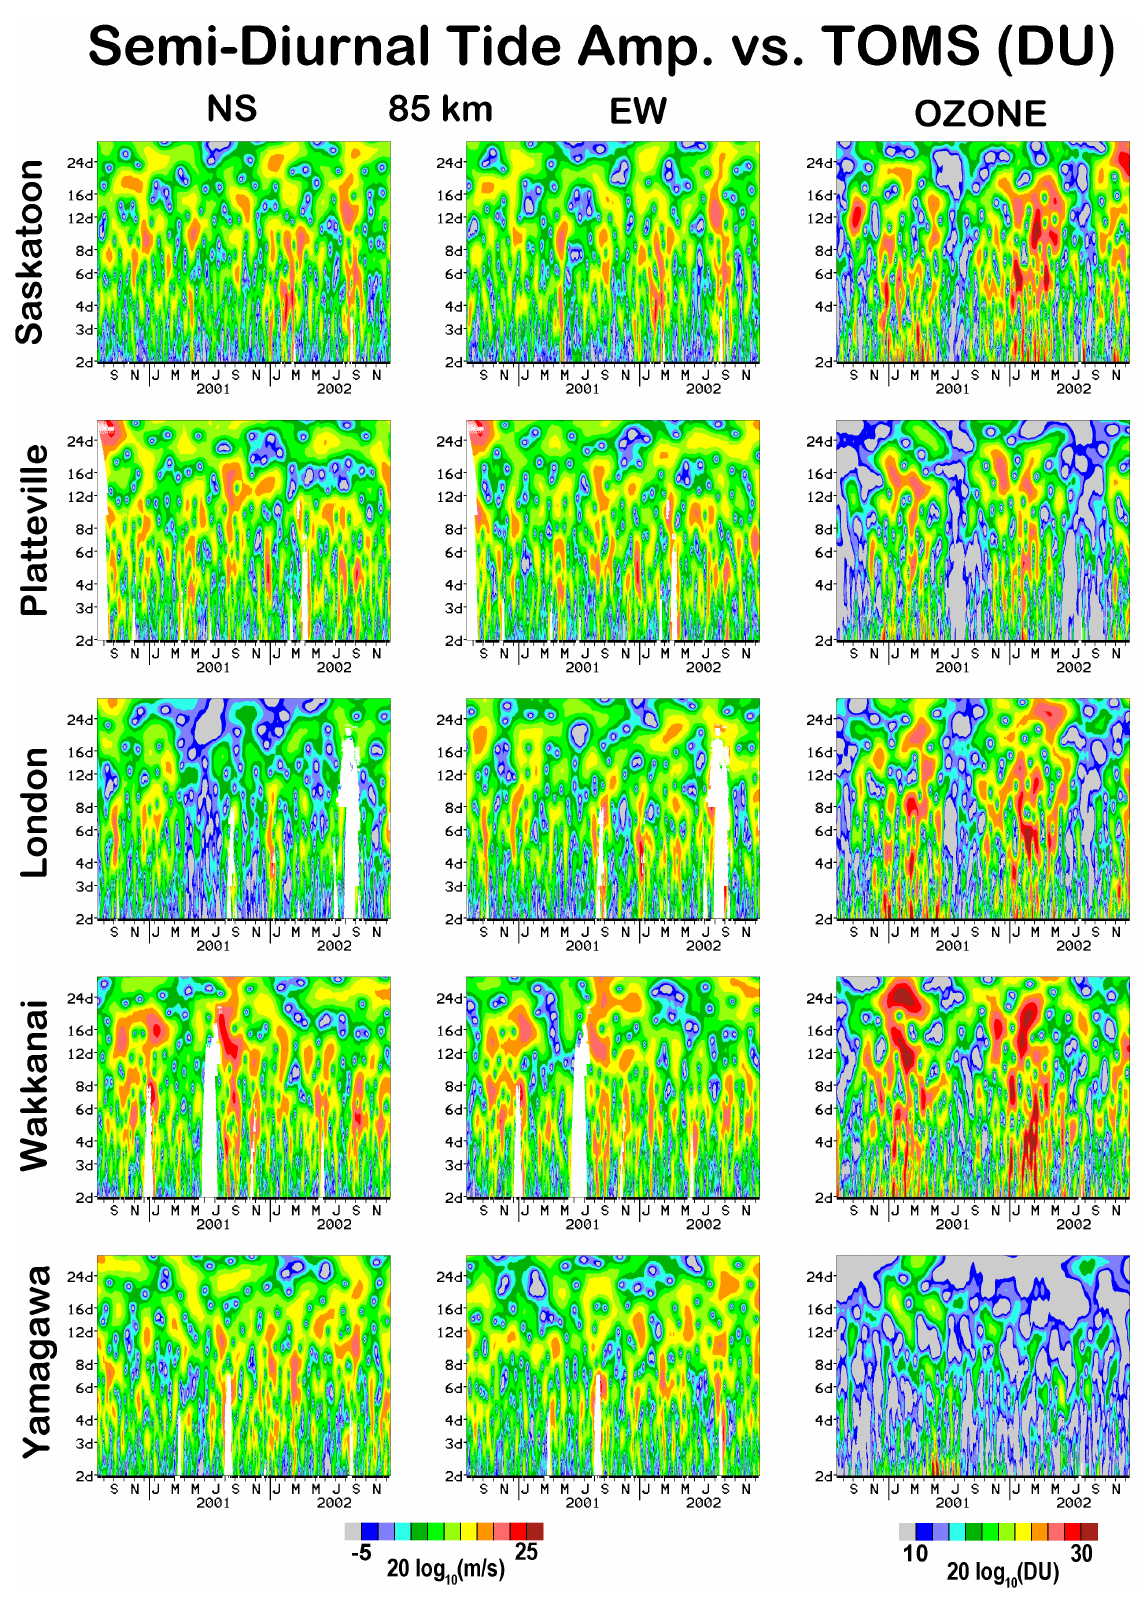
Fig. 3. Wavelet spectral plots for the 85km daily 12-h (semidiurnal) tidal amplitudes (zonal EW, meridional NS) and the ozone (DU) values of TOMS for the radar locations of CUJO